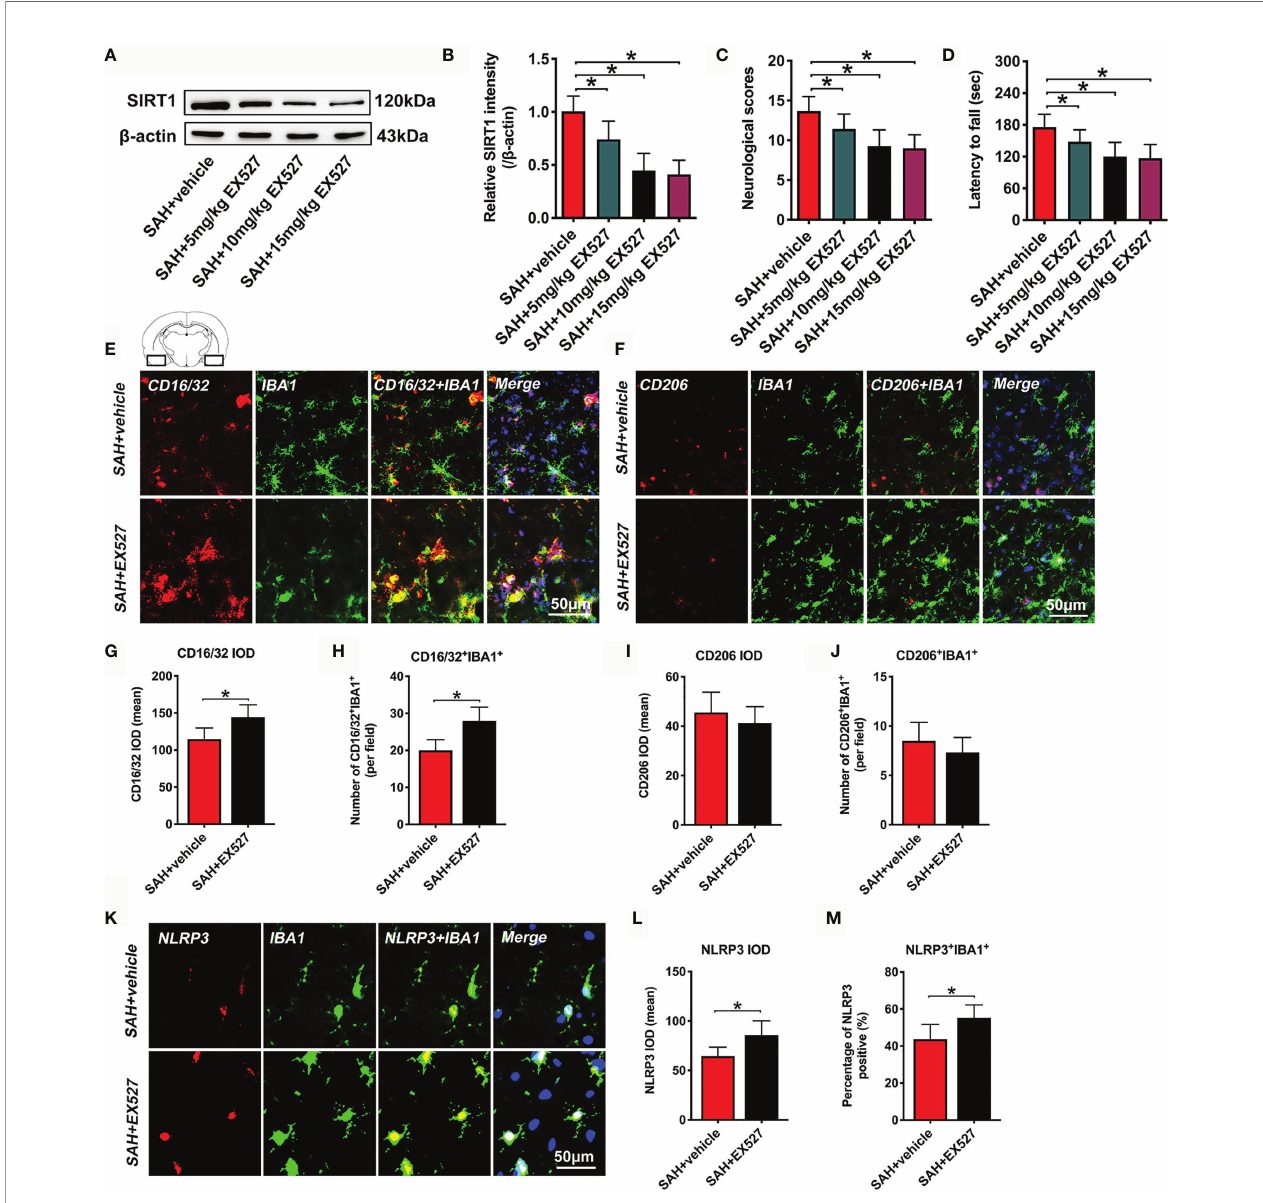
FIGURE 1 | Effects of EX527 on SIRT1 expression, behavior function, microglia polarization, and NLRP3 in fl ammasome after SAH. Representative western blots (A) and quanti fi cation of expression of SIRT1 in all groups (B) . Quanti fi cation of neurological scores (C) and rotarod function (D) in all groups. Representative immuno fl uorescence staining images of M1 phenotype (E) and M2 phenotype (F) , and its quanti fi cation analysis (G – J) . Representative photomicrographs (K) and quanti fi cation of NLRP3 immuno fl uorescence staining (L, M) . For histopathology studies, the basal temporal lobe adjacent to the clotted blood was evaluated. Bars represent the mean ± SD. * P <